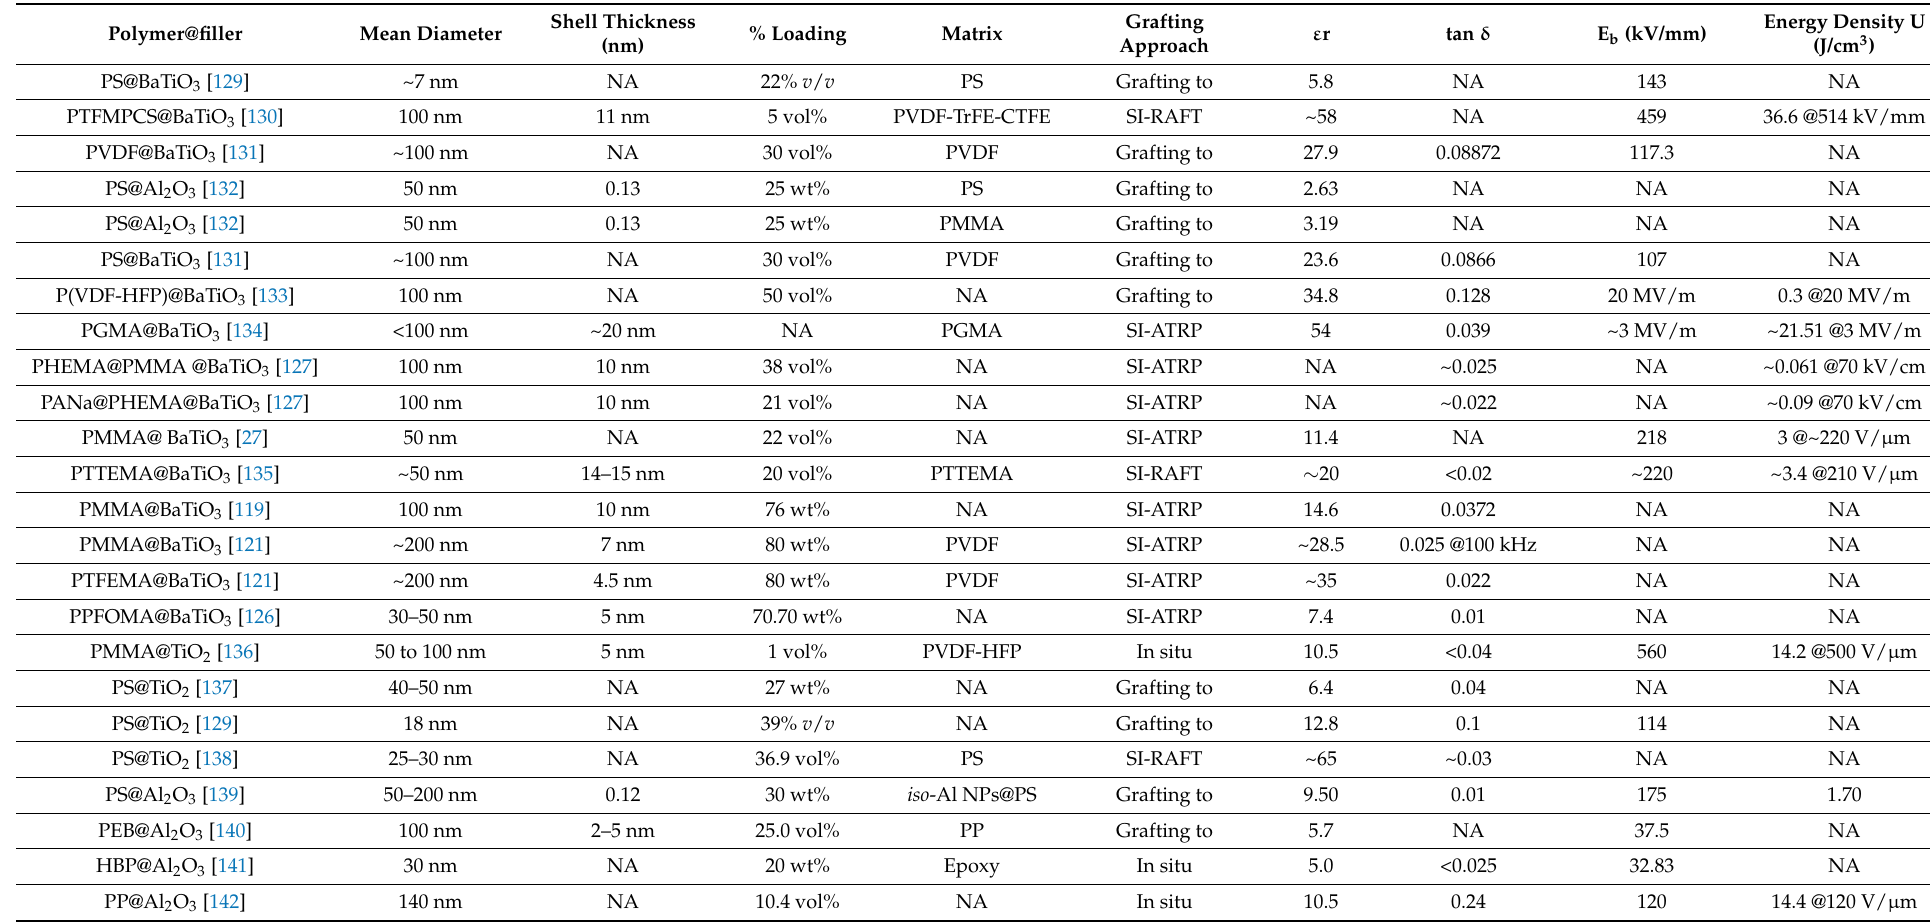
Table 5. Summary of dielectric properties of polymer nanocomposites fabricated from polymer brushes-grafted ceramic